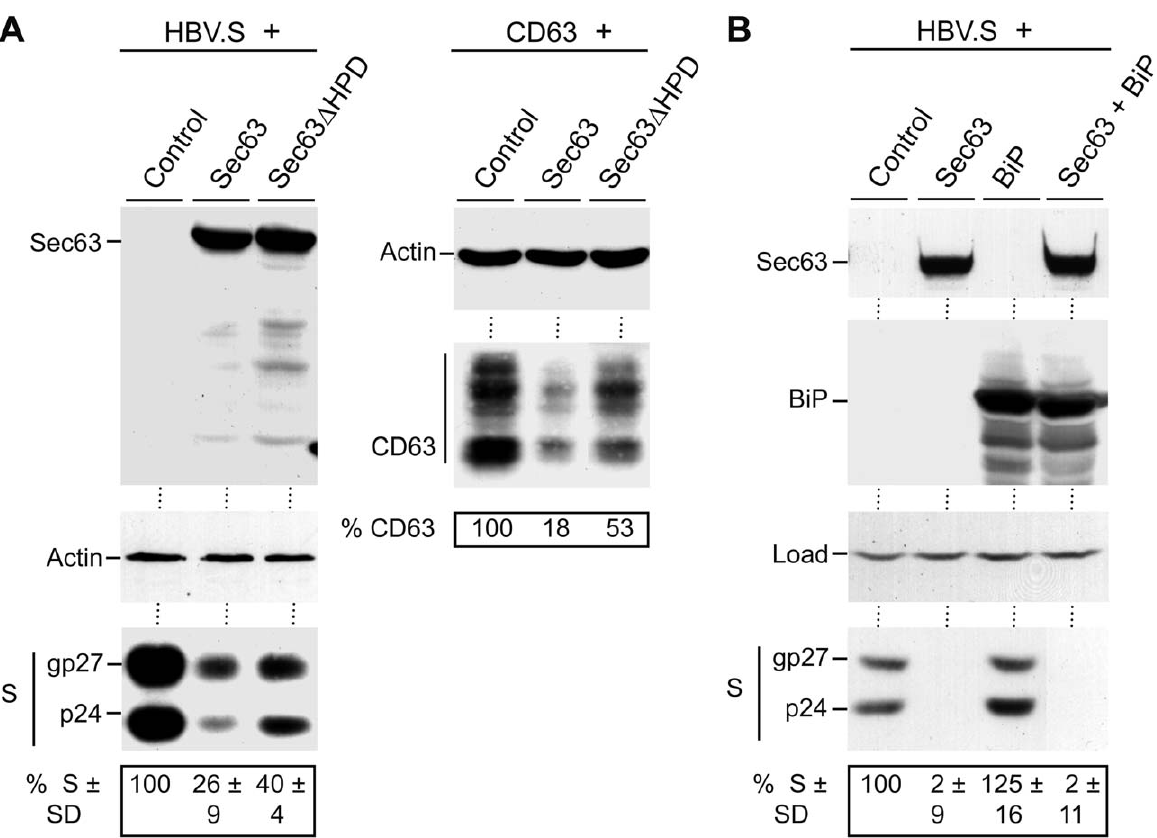
Figure 10. Role of BiP in the action of overexpressed Sec63. A. HuH-7 cells were cotransfected with HBV.S (left panels) or CD63 (right panels) in combination with control DNA or the Myc-tagged wt Sec63 or mutant Sec63 D HPD at a 1:3 DNA ratio, respectively. In case of HBV.S, cellular lysates were subjected to anti-Myc (top), anti- b -actin (middle), and anti-HA (bottom) WB. Relative HBV.S expression values 6 SD ( n =4) were determined as in Fig. 1. In case of CD63, lysates were probed by anti- b -actin (top) and anti-HA (bottom) WB. B. For cotransfections with HBV.S, control DNA, Myc- tagged Sec63, and FLAG-tagged BiP were used as a 1:3 or 1:3:3 DNA ratio, respectively. Cell extracts were probed by WB with antibodies against Myc (top), FLAG (top middle), or HA (bottom). Uniformity of sample loading is shown by a band cross-reacting with the HA antibody (load; bottom middle). Relative HBV.S expression values 6 SD ( n =2) were determined as in Fig. 1.